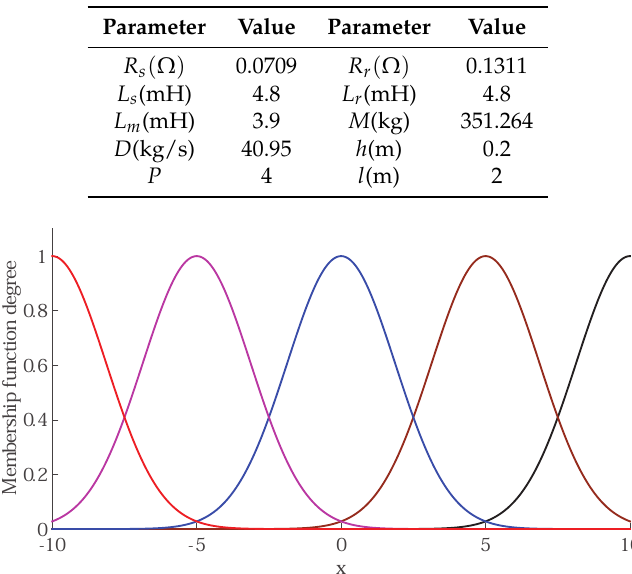
Figure 3. The fuzzy membership